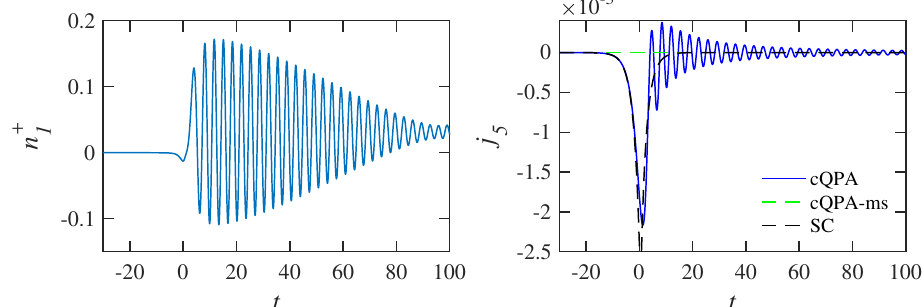
Figure 8. Shown is the integrated number density n + and the integrated axial charge density j 5 (right graph) for a vacuum initial condition in the non- interacting case. We used the same set of mass parameters as in (cid:12)gure